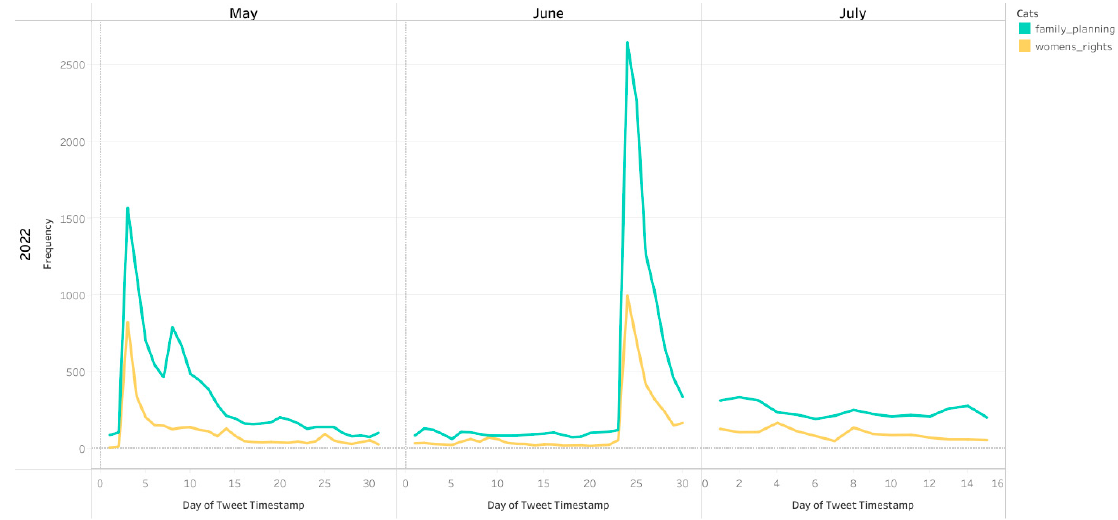
Figure 6. Number of tweets about Women’s Rights and Family Planning across 1 May–15 July 2022.